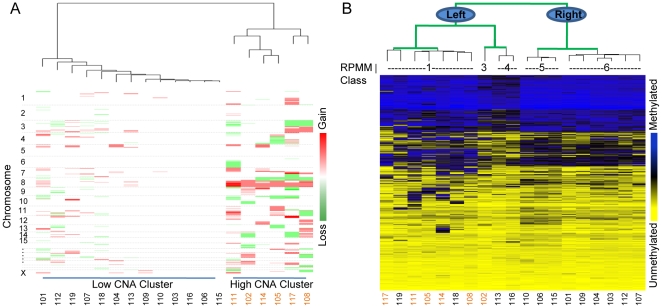
Hierarchical clustering heatmaps for 19 HNSCC tumors.A) DNA copy number states are arranged by chromosome for 500,000 SNP loci. Copy number is red for amplified regions up to 4+ copies, white for 2 normal copies, and green for allele loss to 0 copies. Tumors are ordered by unsupervised hierarchical clustering and are dichotomized into low/high CNA clusters. B) Methylation loci (more methylated = blue, less methylated = yellow) are grouped by Euclidean distance and tumors samples are ordered first by RPMM class structure (green branches) then by simple hierarchical clustering (black branches). Tumor IDs are provided below each plot and “high CNA” samples are colored orange for reference.